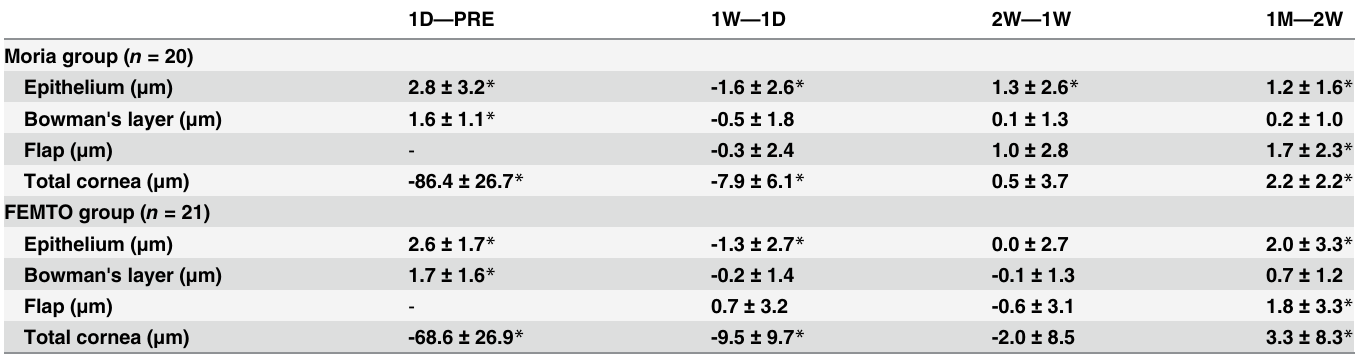
Table 3. UHR-OCT measured changes of central corneal sublayer thicknesses between visits after sub-Bowman 0 s keratomileusis